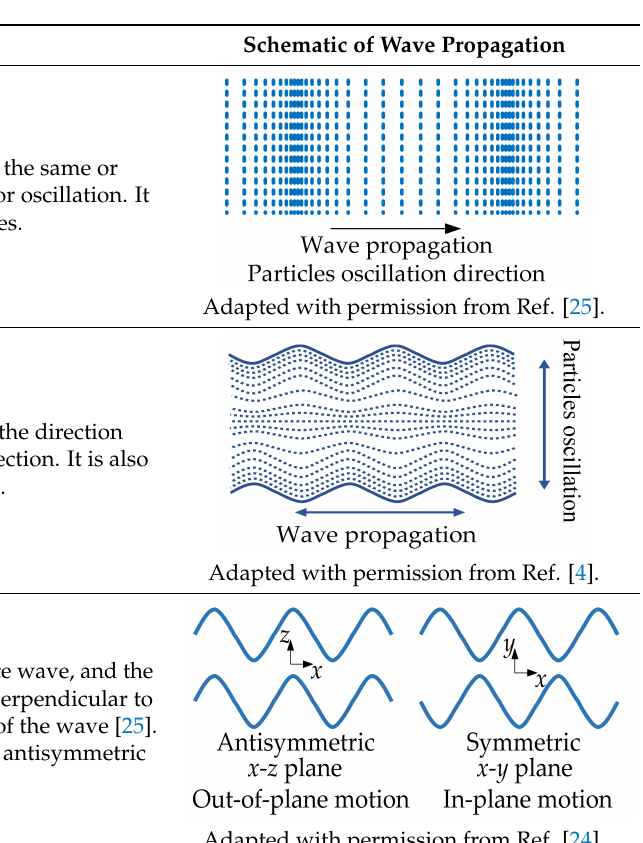
Table 1. Description of several classic